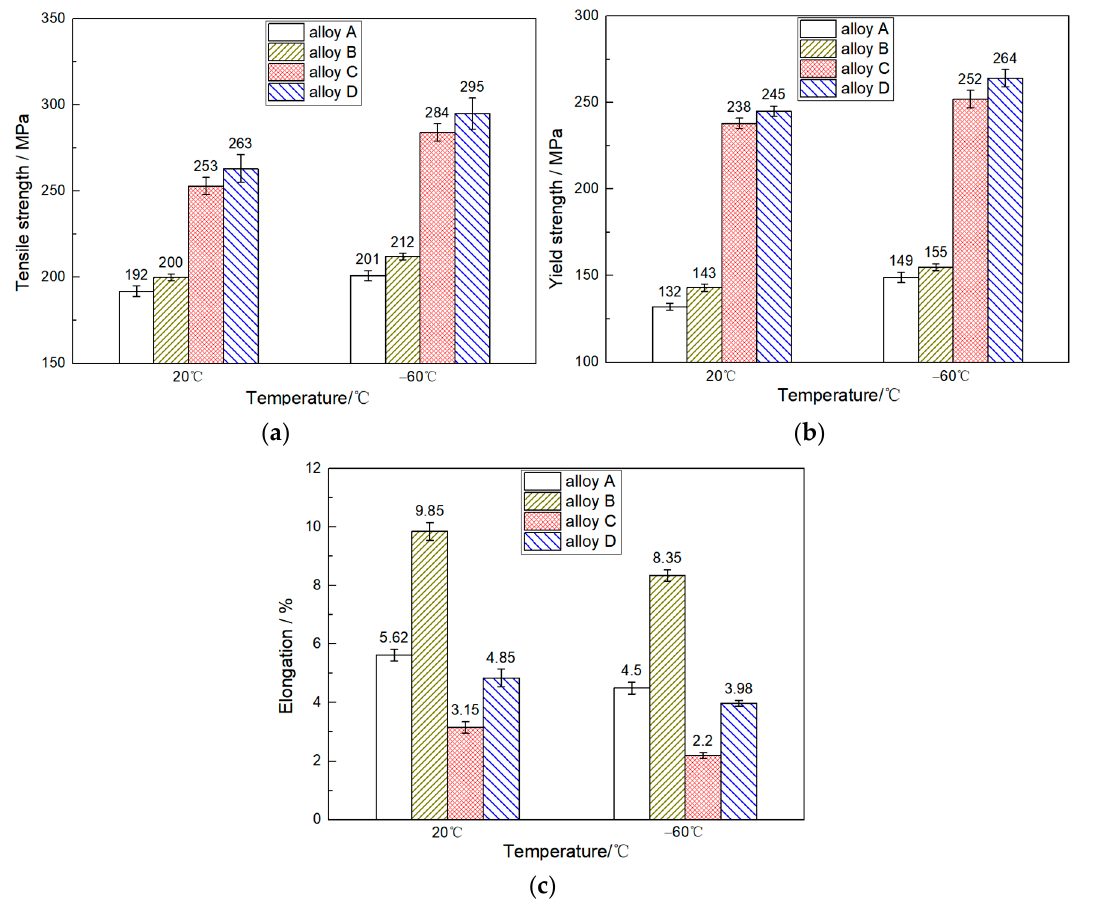
Figure 1. Effect of alloying elements on the tensile properties of Al-Si alloys at room (20 °C) and low ( − 60 °C) temperature: ( a ) Tensile strength; ( b ) Yield strength; ( c ) Elongation.